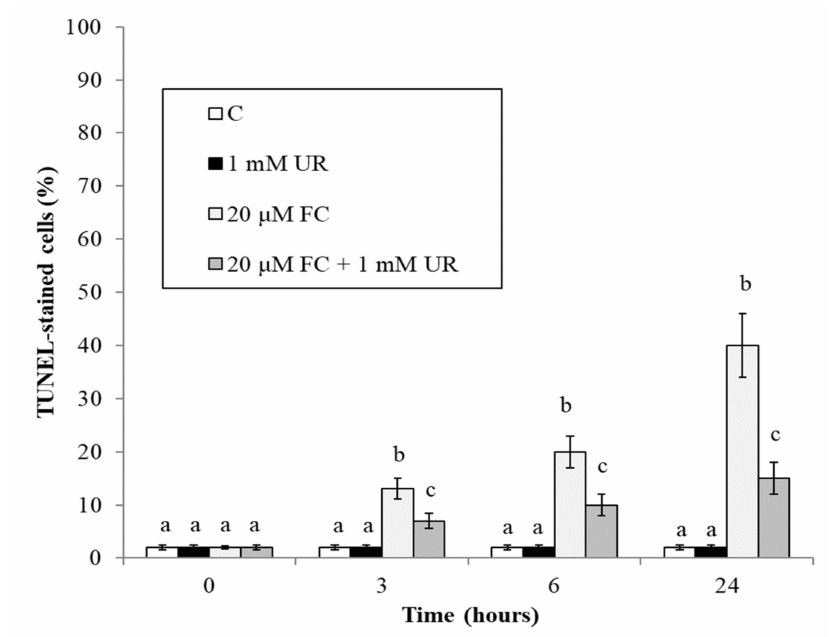
Figure 3. Effect of FC and urate on the appearance of TUNEL-positive cells in the cultures. Means ± SD (n ≥ 9) are shown. Different letters show significant differences among treatments at each time (Tukey HSD test, p ≤